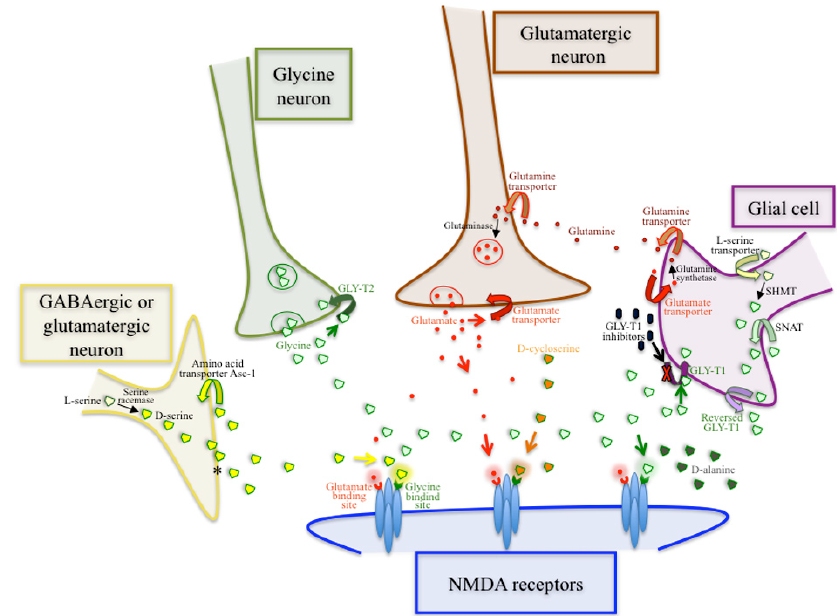
Figure 1. Allosteric modulation of NMDA-R transmission by glycinergic agents. NMDA = N-methyl-D-aspartate; GLY-T1 = type-1 glycine trans- porter; GLY-T2 = type-2 glycine transporter; SHMT = serine hydroxymethyl transferase; SNAT = specific neutral amino acid transporter. *The pathway for D-serine release from neurons is unknown. Glycinergic agents (glycine, D-serine, D-alanine or D-cycloserine) are obligatory co- agonists at the strychnine-insensitive glycine binding site of NMDA receptors. Small amounts of glycine are released from glycinergic neurons and are taken back up by a GLY-T2 located in these neurons. However, most of the glycine available in the synaptic cleft is released by glial cells through a reversed GLY-T1. Glycine can be taken up into glial cells by GLY-T1 or through a glial specific neutral amino acid transporter. Glycine can also be converted from L-serine in glial cells through SHMT action. It is noteworthy that glycine reuptake by GLY-T1 in glial cells limits the availability of glycine in the synaptic cleft. L-serine can also be converted to D-serine by serine racemase in GABAergic or glutamater- gic neurons. D-serine availability in the synaptic cleft is limited through its reuptake by amino acid transporter Asc-1 located in these